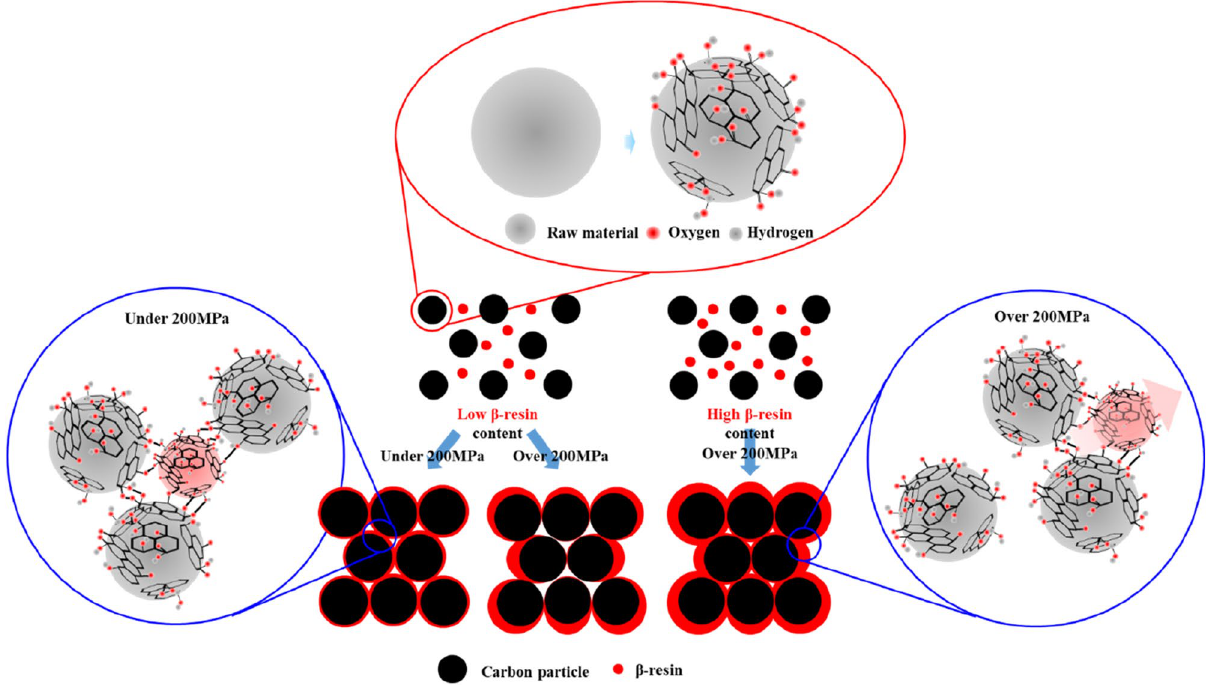
Figure 10. Effect of β-resin content on mechanical properties of high-density carbon blocks depending on molding